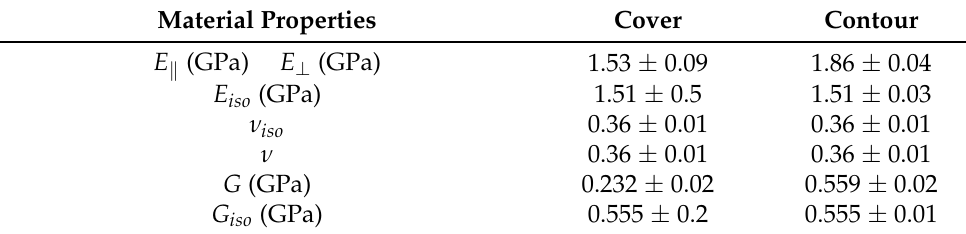
Table 3. ABS/PC properties for the cover and contour